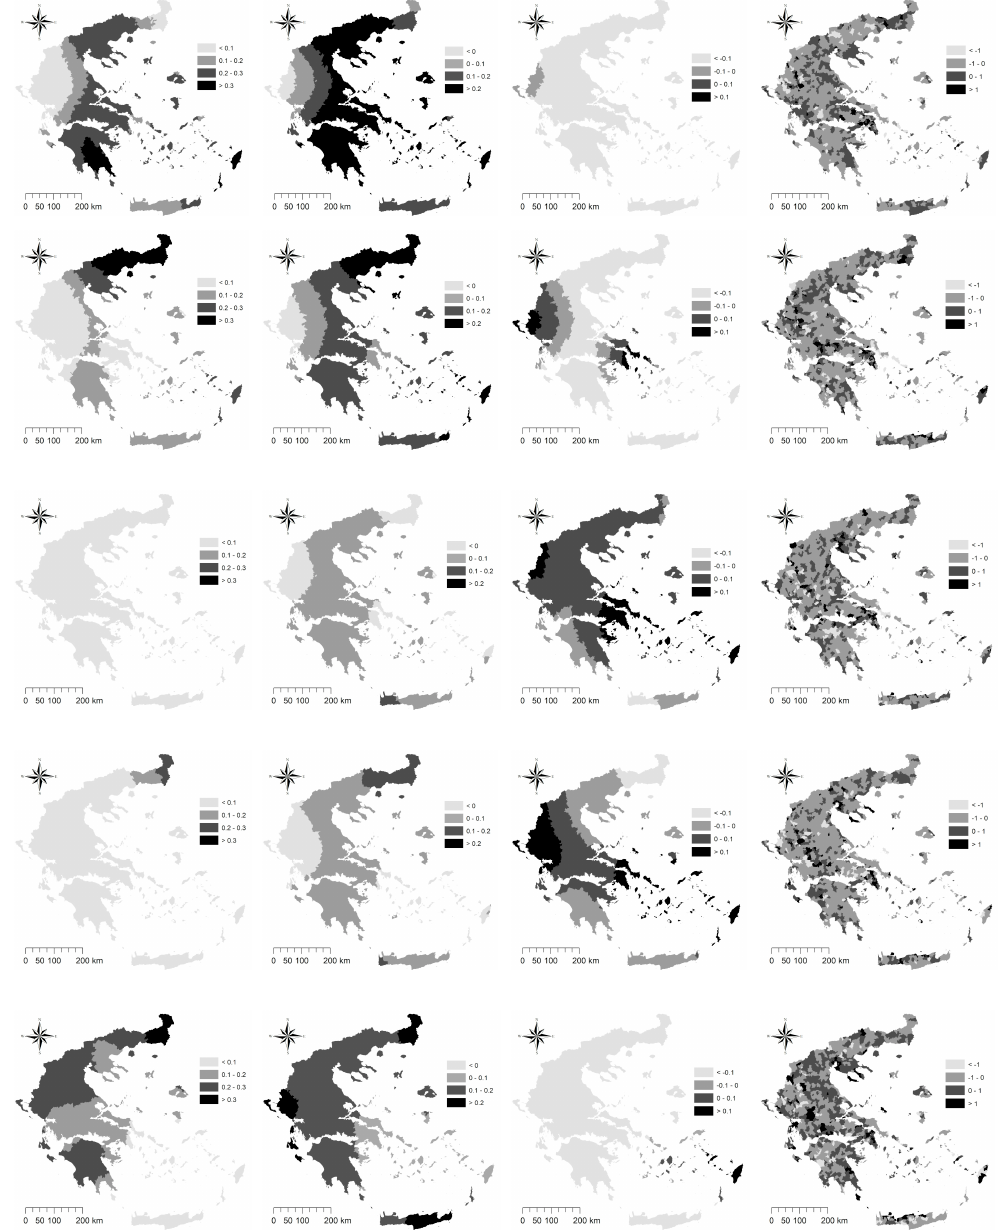
Figure 6. Results of geographically weighted regression (GWR) models with population growth rate (%) as the dependent variable and population density as a predictor (from left to right: local R 2 , slope coe ffi cient, model intercept and standardized residuals; from top to bottom: 1961–1971, 1971–1981,